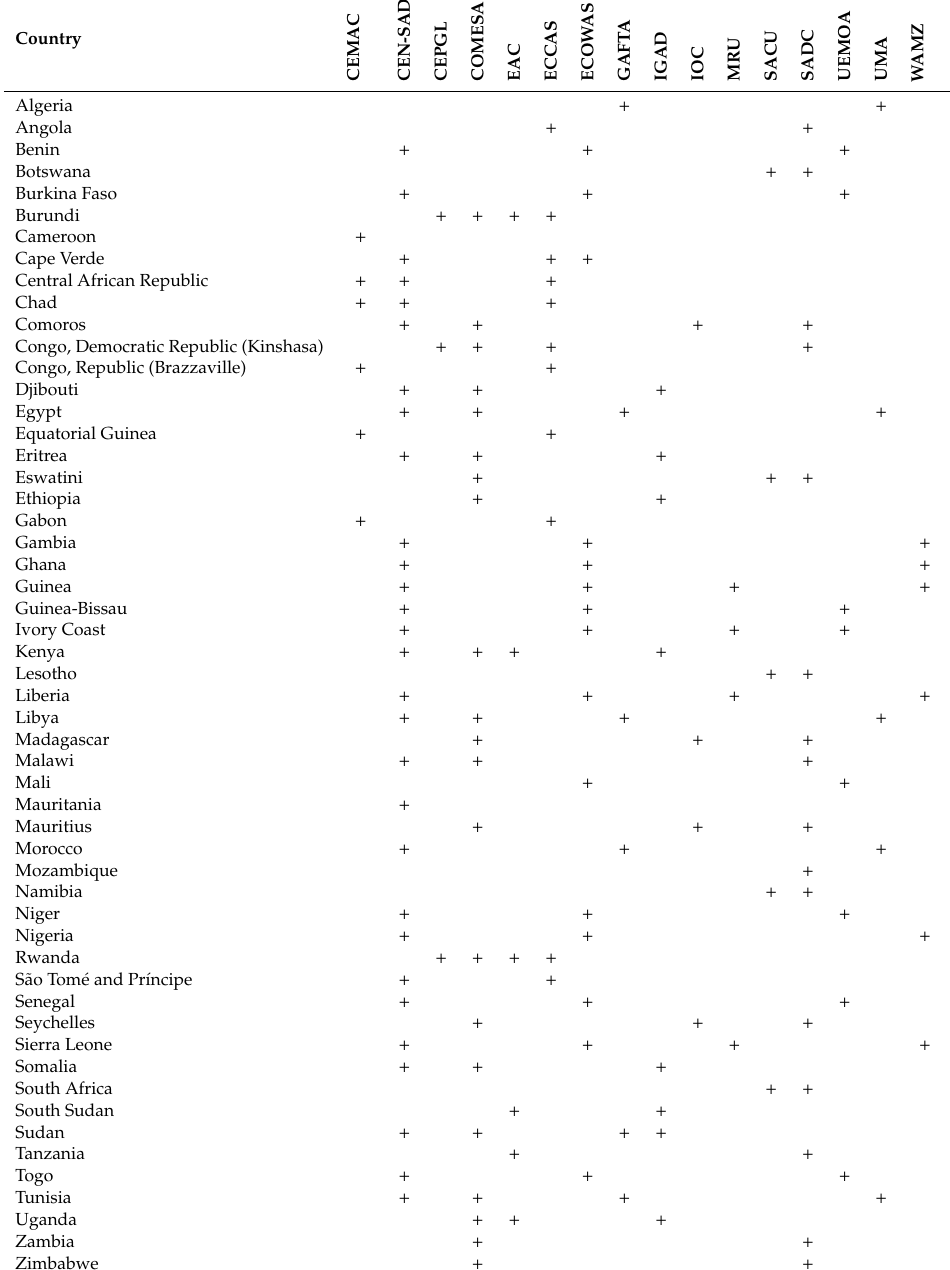
Table 2. A ffi liations of African nations to the di ff erent trading blocks. See text for abbreviations. Blocks not addressing food issues were